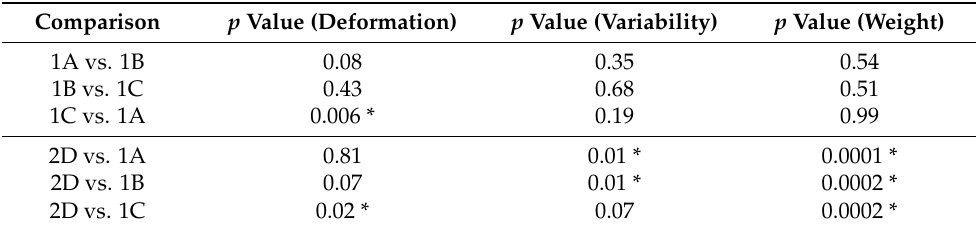
Table 4. Pair-wise group comparison: Deformation, Deformation Variability, and